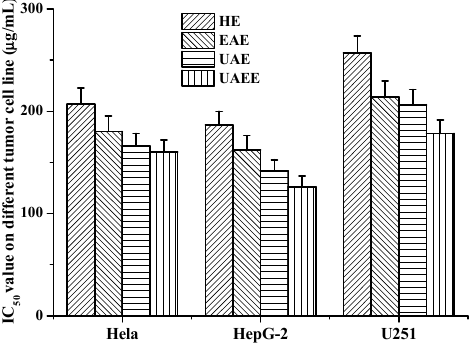
Figure 5. Antitumor activities (IC 50 μ g/mL) of phenolic extracts obtained from different extraction methods on the Hela, HepG-2 and U251 cells.